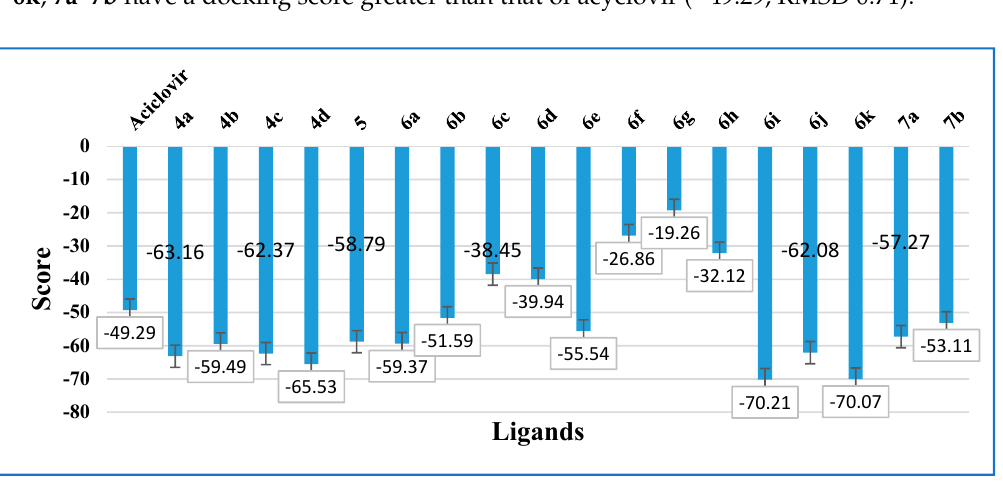
Figure 4. Docking score of the compounds.